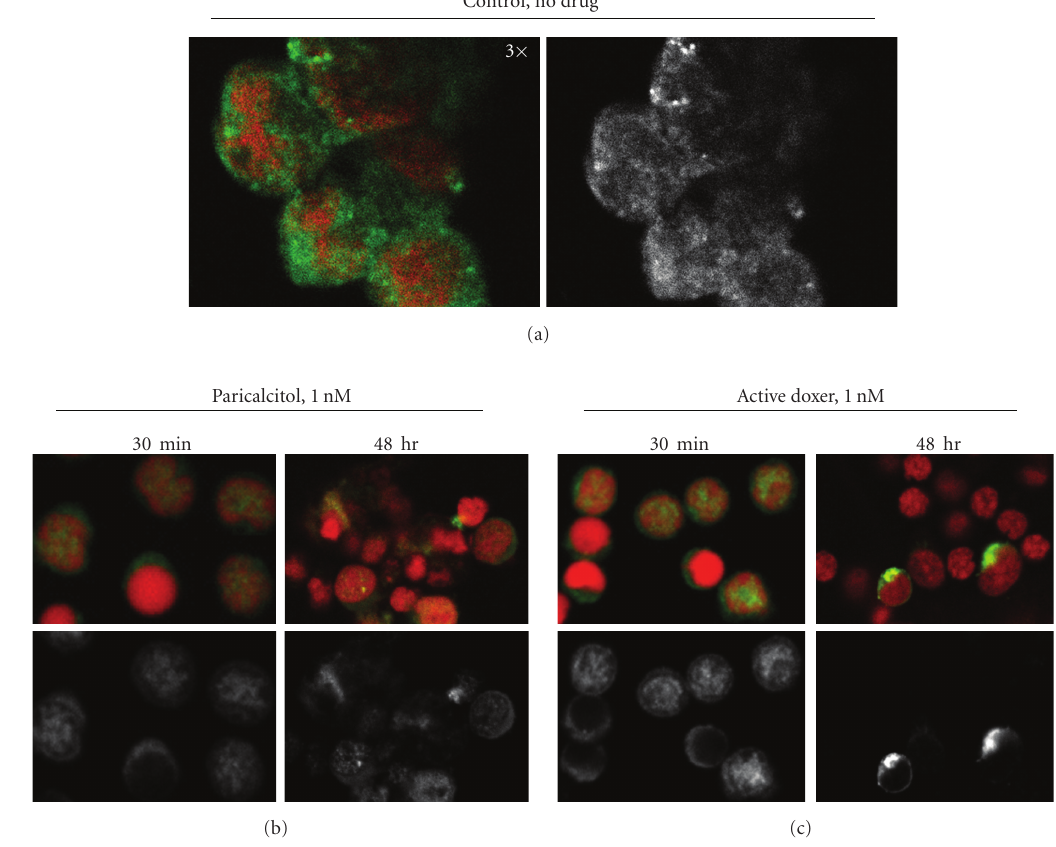
Figure 7: Localization of VDR in pig parathyroid cells. Cells were incubated without (a) or with 1nM paricalcitol (b) or active doxercalciferol (c) for 30 minutes or 48 hours, and then stained for VDR (green) and nucleus (red). The VDR staining alone was also shown in black and white. (a): 3 × magnification; (b) and (c): 2 × magnification; doxer: